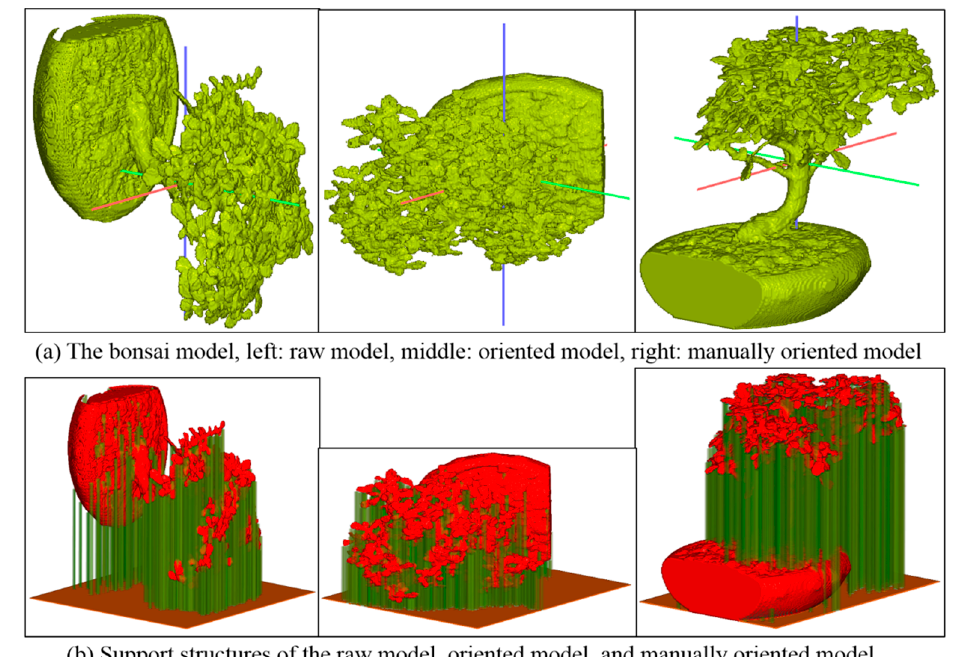
Figure 10. Images of the bonsai model: ( a ) the raw, oriented, and manually oriented models; ( b ) support structures of the raw, oriented, and manually oriented models.